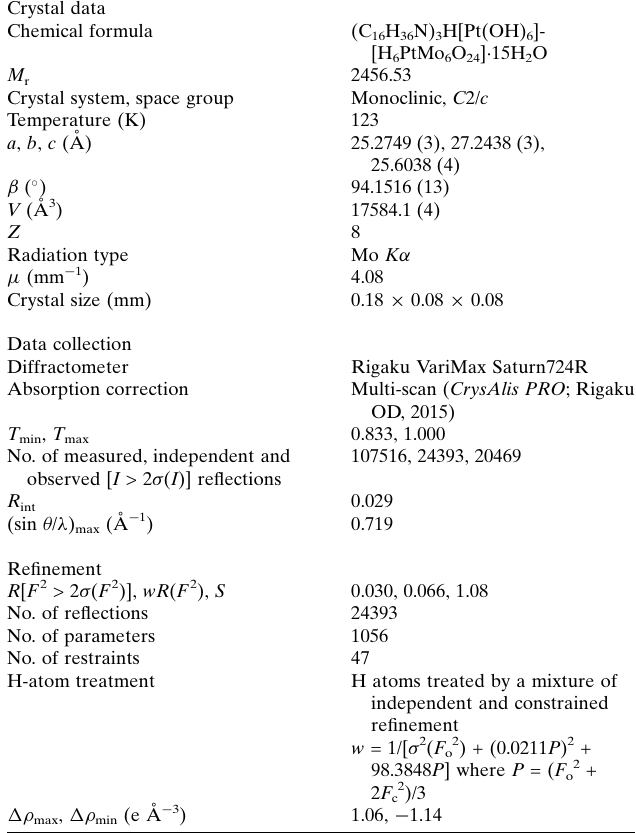
Table 3 Experimental details. Crystal data Chemical